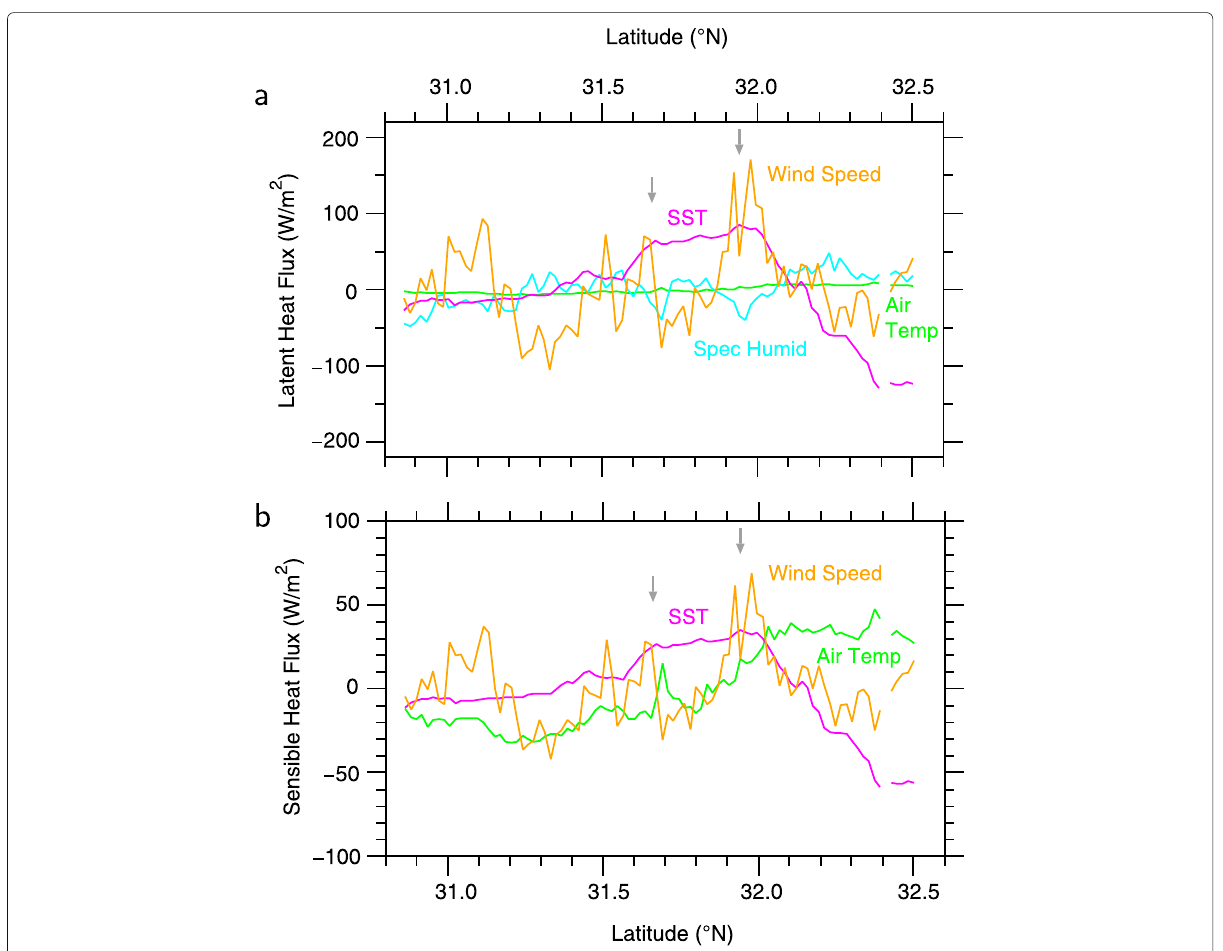
Fig. 8 Spatial variation components in a latent and b sensible heat fluxes on track A due to wind speed, (∂ F /∂ U W )(cid:2) U W in Eq.(1) (orange line), sea surface temperature (SST) (∂ F /∂ T S )(cid:2) T S (magenta line), air temperature (∂ F /∂ T A )(cid:2) T A (green line), and specific humidity (∂ F /∂ q )(cid:2) q (cyan line). Values were averaged within intervals of approximately 2km. Gray arrows are the same as the red arrows in Fig. 7. In b , sensible heat flux variations due to specific humidity variations are not plotted because sensible heat flux is independent of specific